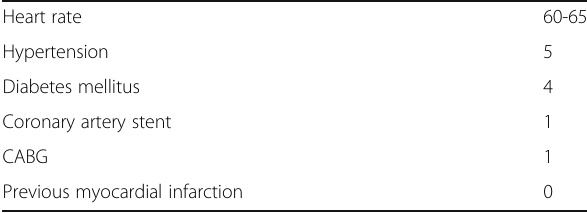
Table 1 Clinical characteristics of the study population Heart rate